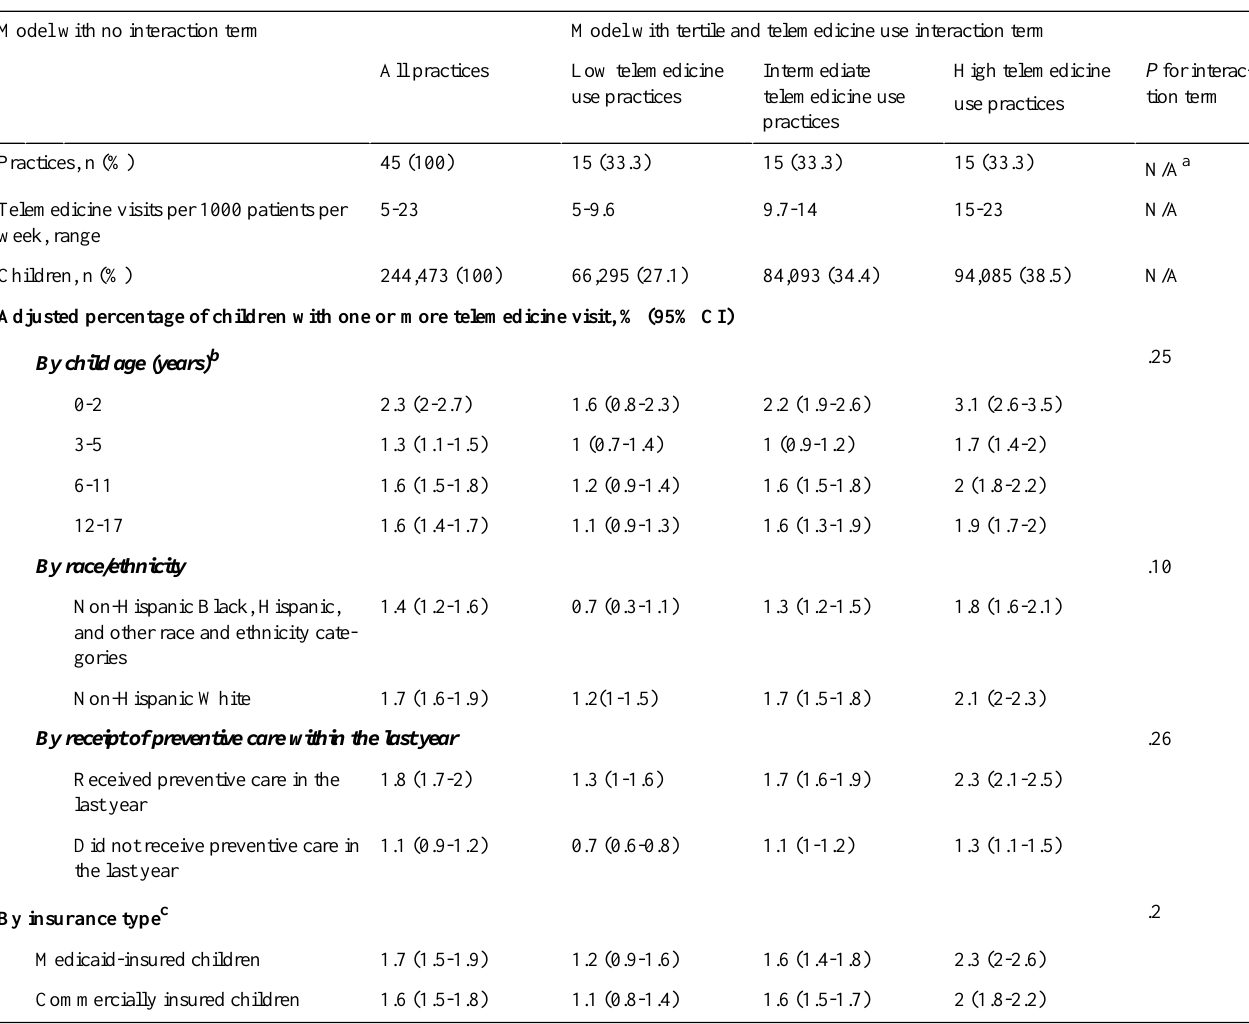
Table 4. Variation in telemedicine visits by child characteristic across practices with low, intermediate, and high telemedicine use. Adjusted percentages of children in patient panels who had one or more telemedicine visits during the study period using logistic regression clustered by practice. Italicized variables are significant in the entire population. P values indicate the significance of the interaction term between the specified characteristic and practice